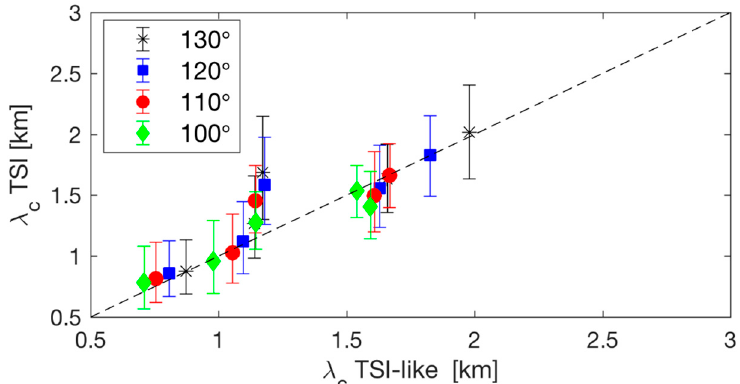
Figure A6. Comparison of TSI to TSI-like characteristic cloud size ( λ c ) from 1000 simulated cloud fields drawn from the cumulative distribution functions. Symbols indicate ensemble mean λ c and error bars depict 95% confidence intervals for TSI. The maximum FOV is set to 130° (black asterisk), 120° (blue square), 110° (red circle) and 100° (green diamond). Differences between the TSI and TSI-like results are due to several factors, such as sensor differences (including sun glare), inclusion of cloud sides, evolution of cloud fields over the 1-h analysis period and the 2D interpolation.